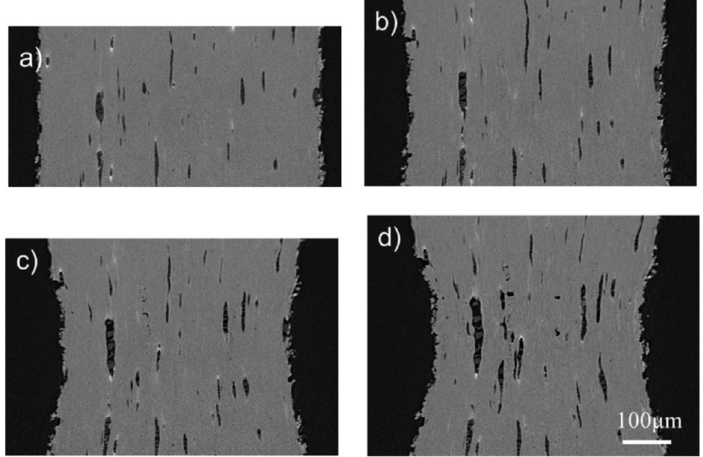
Figure 7. Experimentally determined relation between density of voids and plastic strain in JIS SUM24L free ‐ cutting steel, from [54].